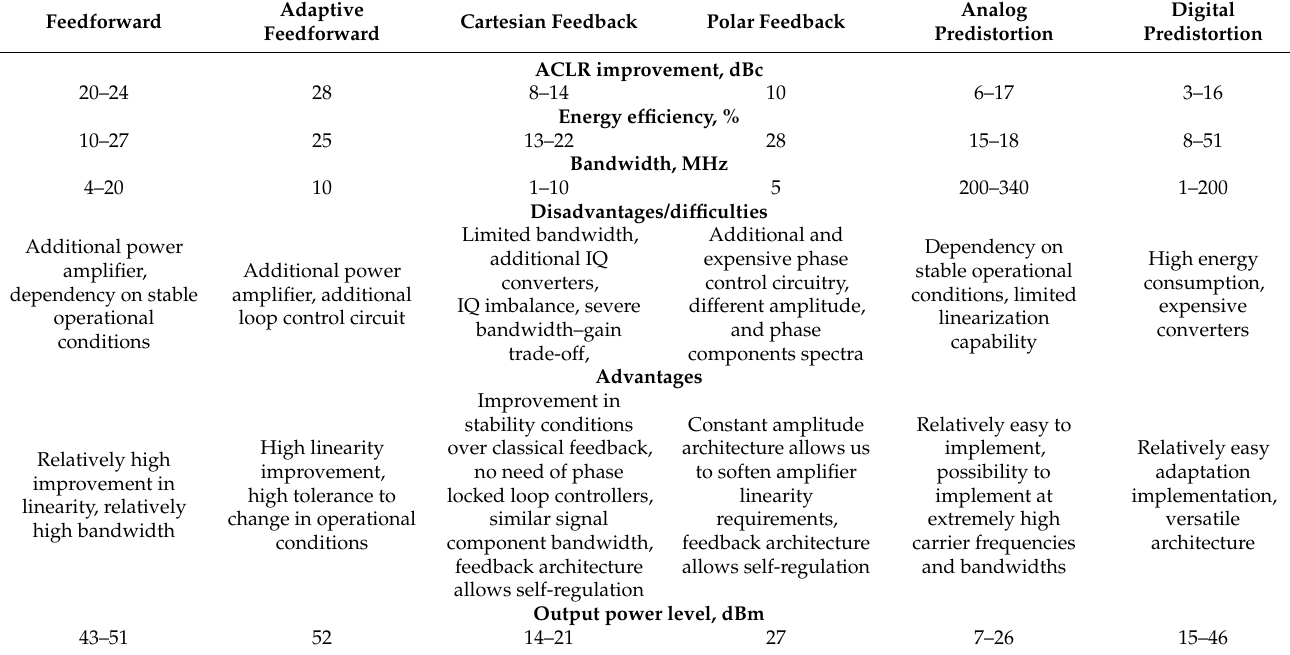
Table 4. Linearization methods